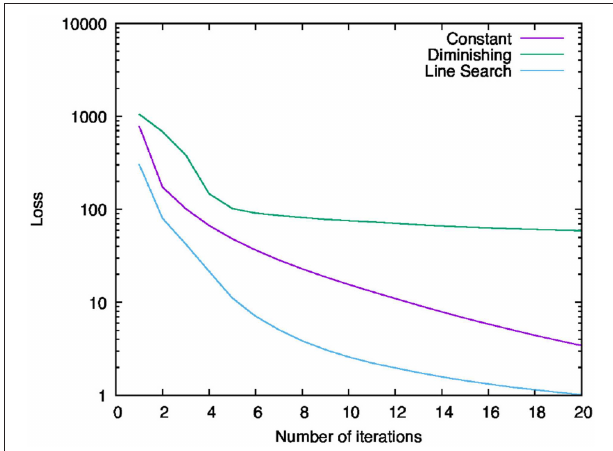
FIGURE 4 | Behavior of the values of the objective function for each iteration.